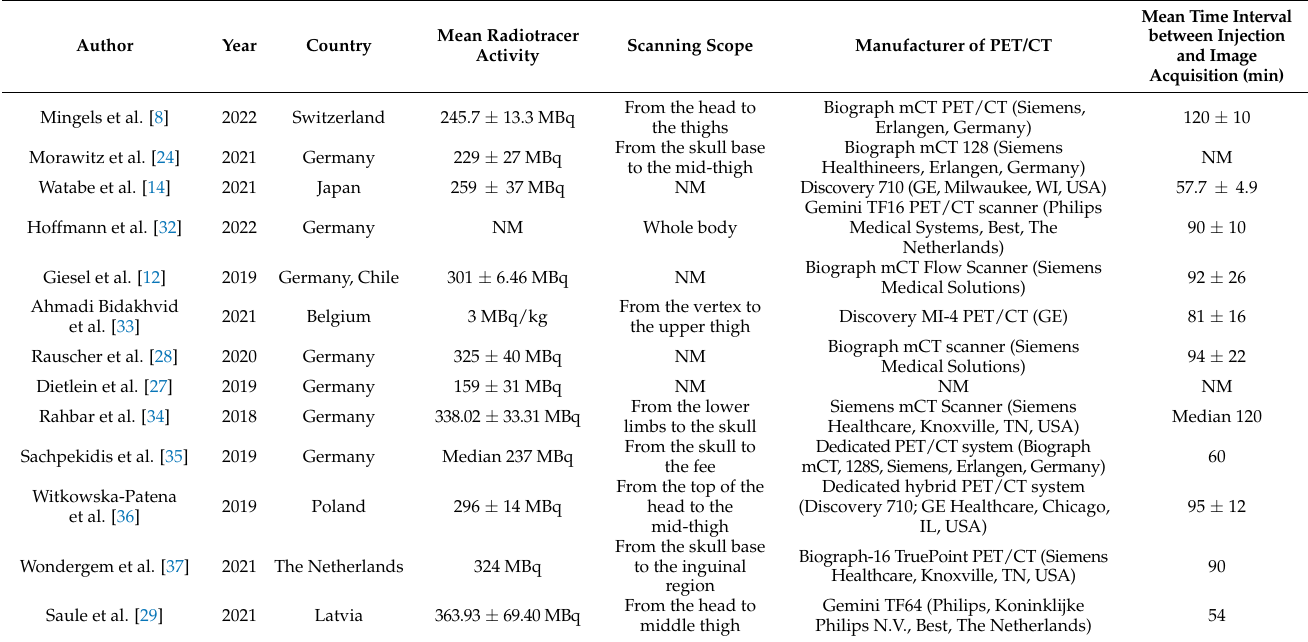
Table 2. Technical aspects of 18 F-PSMA-1007